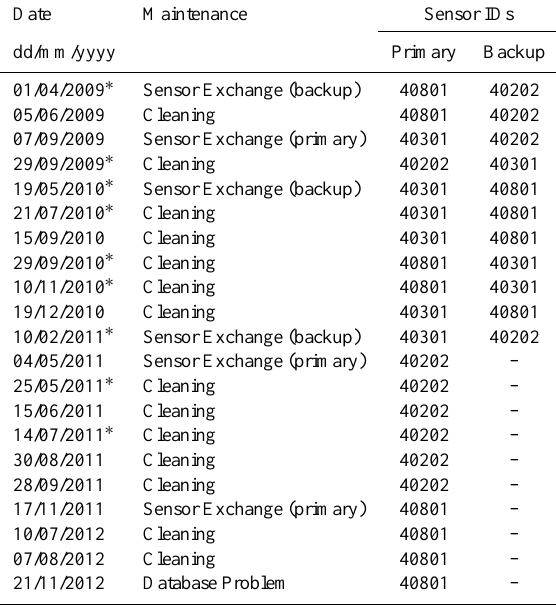
Table A2. Maintenance times of the water level pressure sensor between April 2009 and November 2012. Dates marked with a “*” were not used during the trend